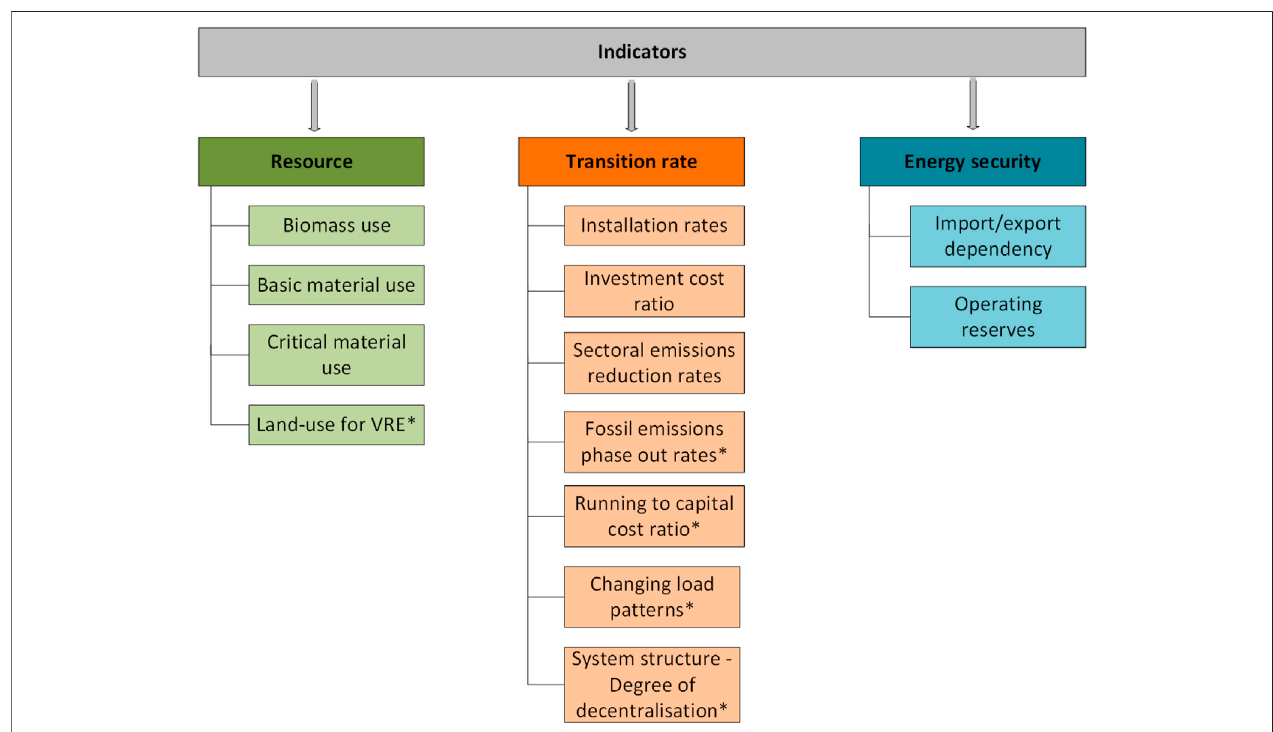
FIGURE 1 | Schematic overview of the indicators. Indicators marked with an asterisk are presented in the Supplementary Material .